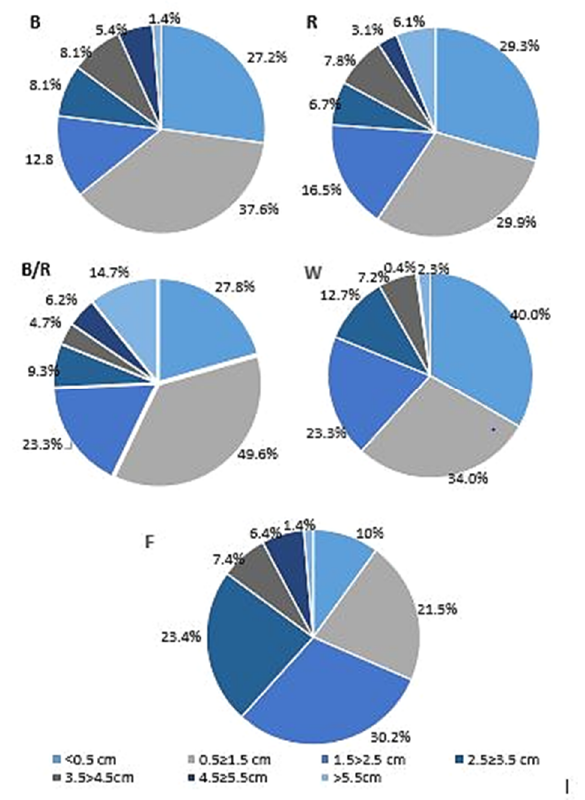
Figure 2. The effect of light conditions: (B) blue, (R) red, (B/R) blue/red, (W) white, (F) fluorescent on length shoots D. forrestii (based on the results from three independent experimental replicates).